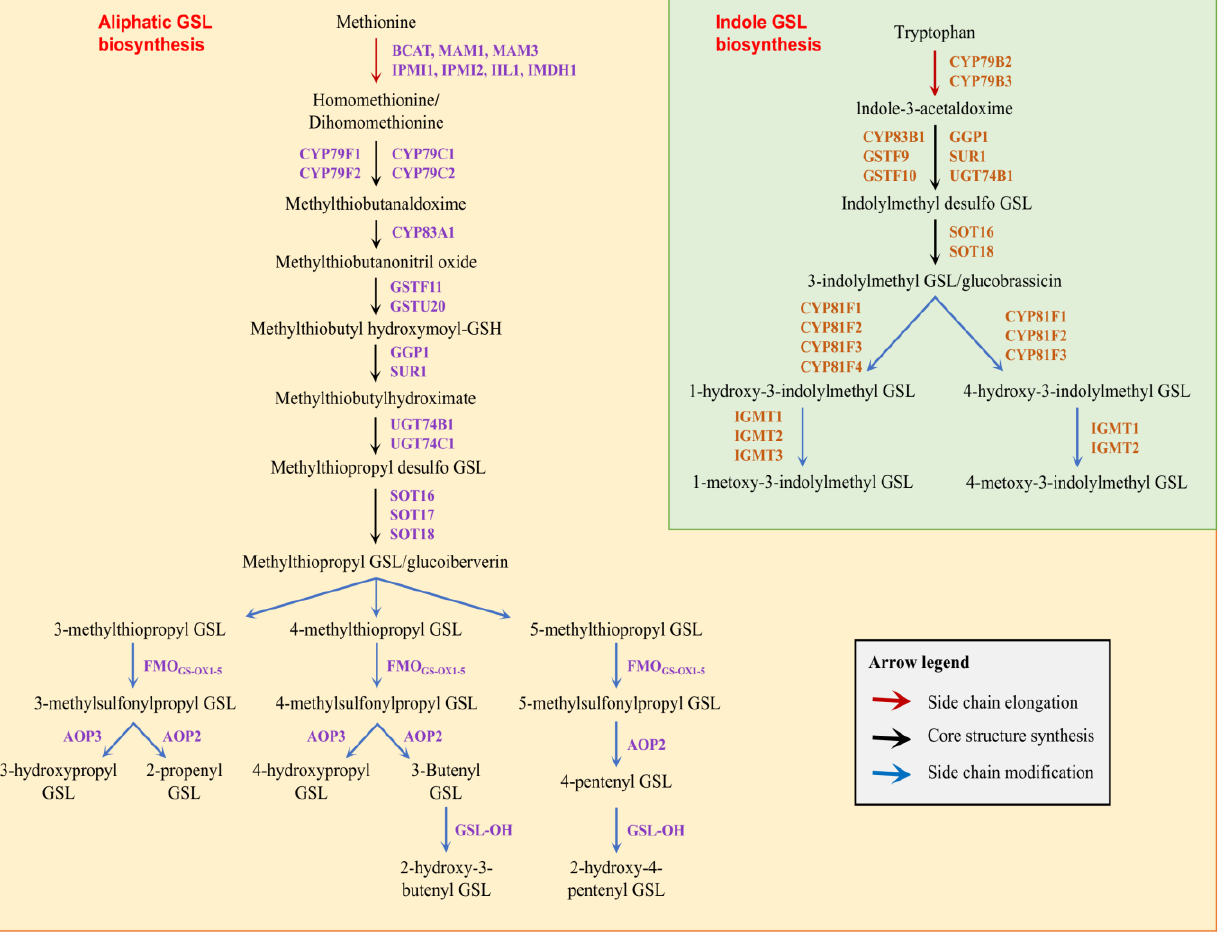
Figure 1. Roadmap for glucosinolate biosynthesis. The compound beside the direction line is the catalytic enzyme, and the compound that the direction line points to is the reaction product.